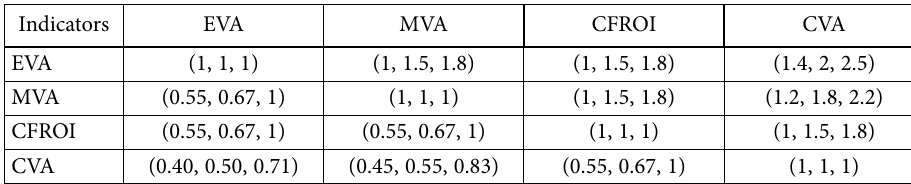
Table 2. Fuzzy pair-wise comparison matrix for the sub-criteria of the VFP (value based financial performance) main-criteria